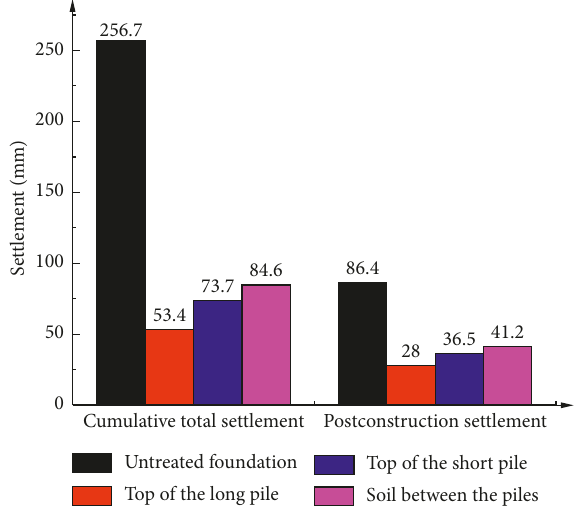
Figure 8: Total cumulative settlement and postconstruction settlement.